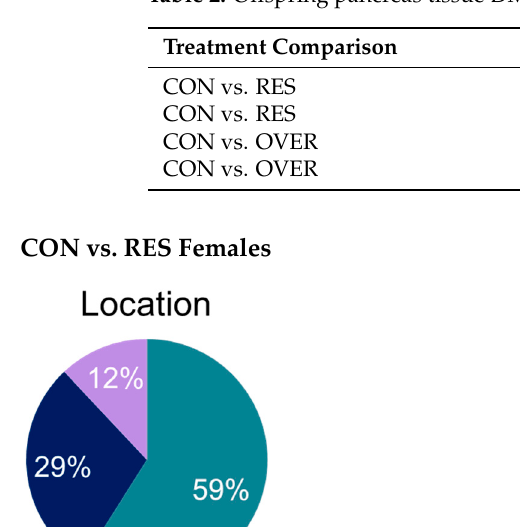
Table 2. Offspring pancreas tissue DML and DMRs.